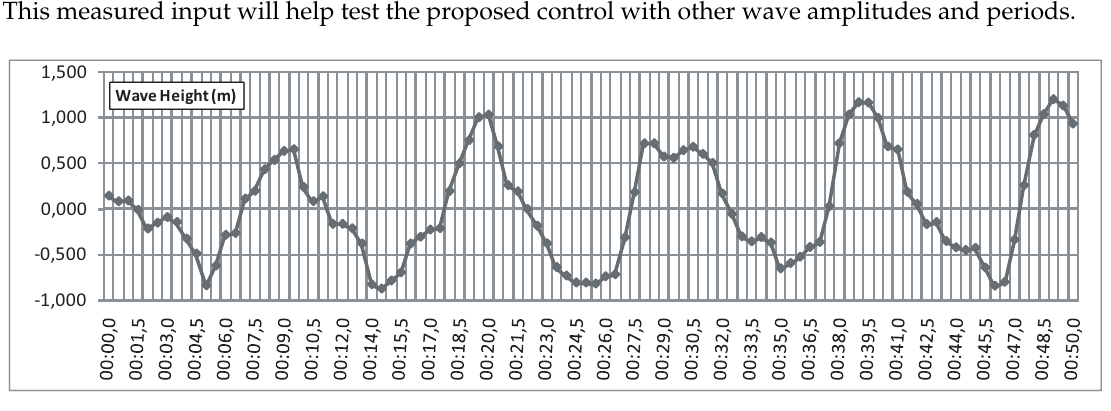
Figure 19. Measured wave input to the implemented OWC model.